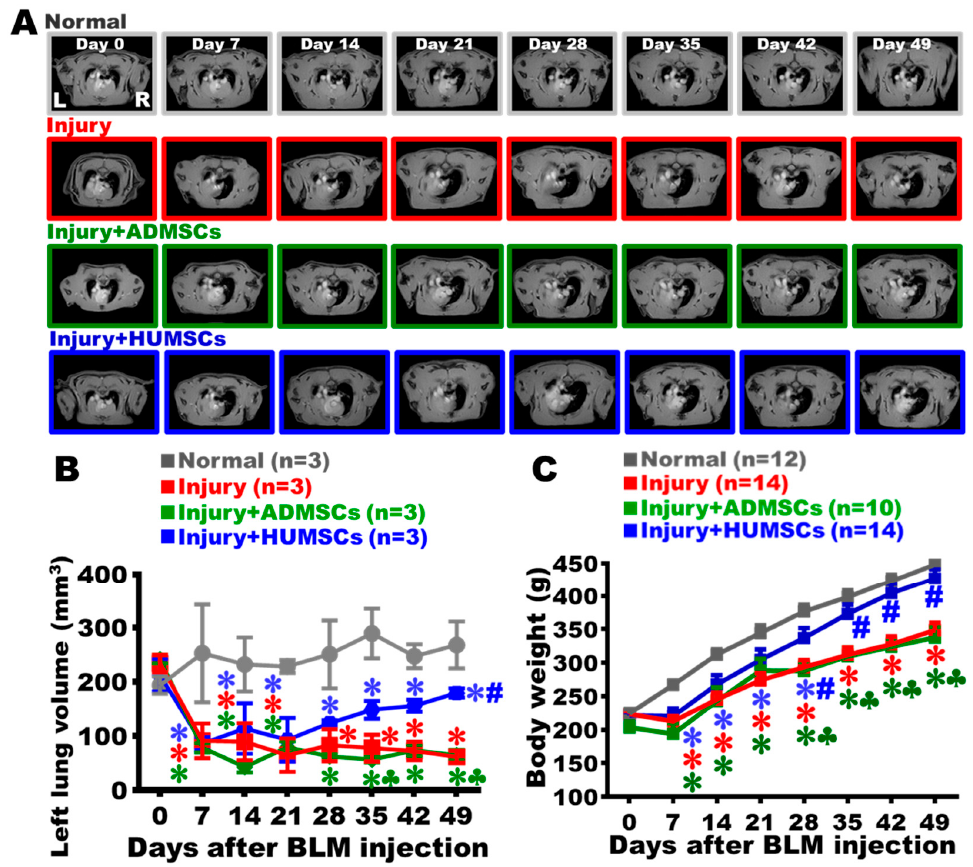
Figure 2. Transplantation of HUMSCs, but not ADMSCs, increased the alveolar volume in PF rats. The horizontal level of the trachea carina is shown in the MRI of the rat thoracic cavity. L stands for the left lung, R for the right lung ( A ). The carina was established as a reference point for image placement. In addition to the carina-containing slice, four images were acquired below the carina. To calculate the left-lung alveolar volume for each rat, the five pictures were added together and the black alveolar space was quantified. The black alveolar space in these five images was quantified to represent the left-lung alveolar volume of each rat. The findings indicated that the alveolar volume drastically decreased following BLM damage. The alveolar volume was significantly increased by the HUMSCs transplantation ( B ). Weekly weighing showed that HUMSCs transplantation improved the body weight of rats with PF ( C ). The figure shows the number of rat samples in each group. ✽ : p < 0.05 (vs. the Normal group); #: p < 0.05 (vs. the Injury group); ♣ : p < 0.05 (the Injury+ADMSCs group vs. the Injury+HUMSCs group).